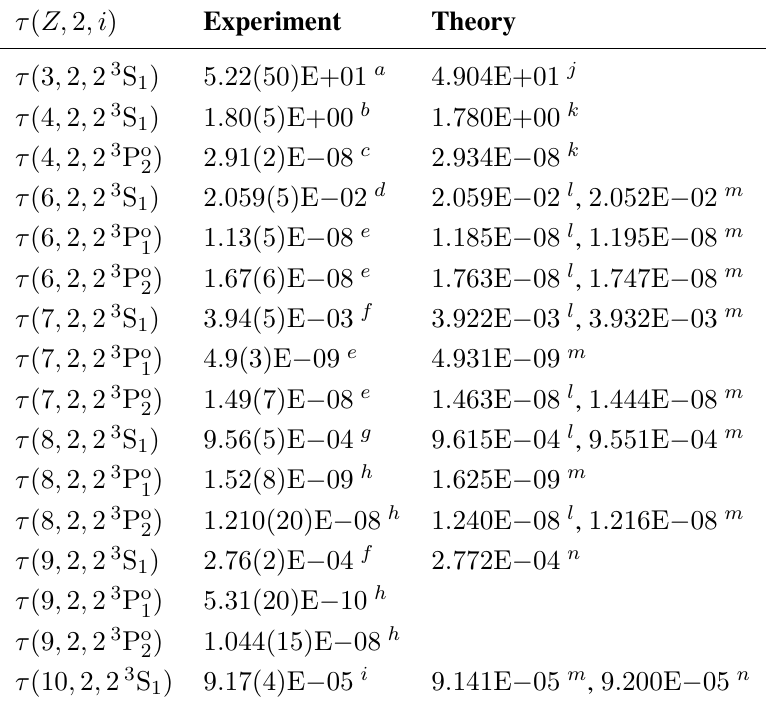
Table 7. Experimental and theoretical lifetimes (s) for states in He-like ions. a [141]; b [132]; c [142]; d [143]; e [144]; f [145]; g [146]; h [147]; i [148]. Theory: j [88]; k [149]; l [150]; m [121]; n [105]. Note: the quantity in brackets gives the experimental error.